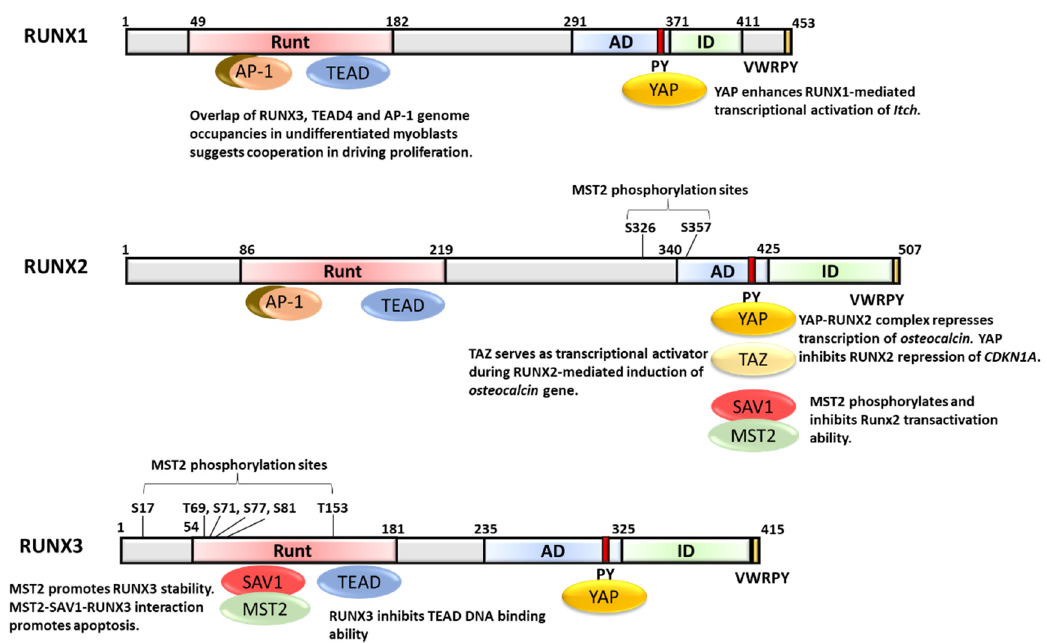
Figure 1. Conserved domains of human RUNX proteins and their interactions with YAP-Hippo associated proteins. The numbers indicate amino acid positions in human RUNX1 (NP_001001890.1), RUNX2 (NP_001356334.1) and RUNX3 (NP_004341.1). For RUNX2, the corresponding MST2 phosphorylation sites in the longer RUNX2 isoform NP_001019801.3 are S347 and S378 (as stated in the text). Runt, AD and ID refer to the DNA binding, activation and inhibitory domains, respectively.